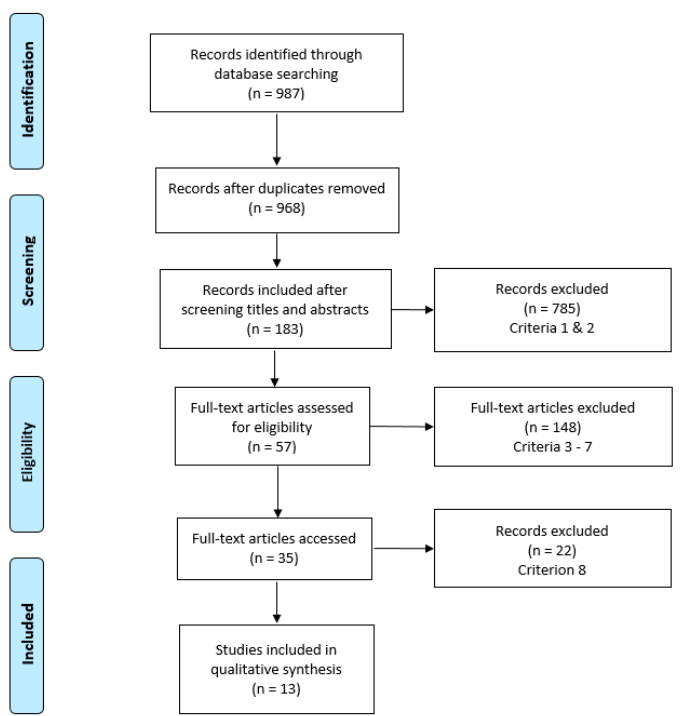
Figure 1. Number of papers included and excluded throughout the stages of the systematic review process. Descriptions of each criteria are reported in Table 1.